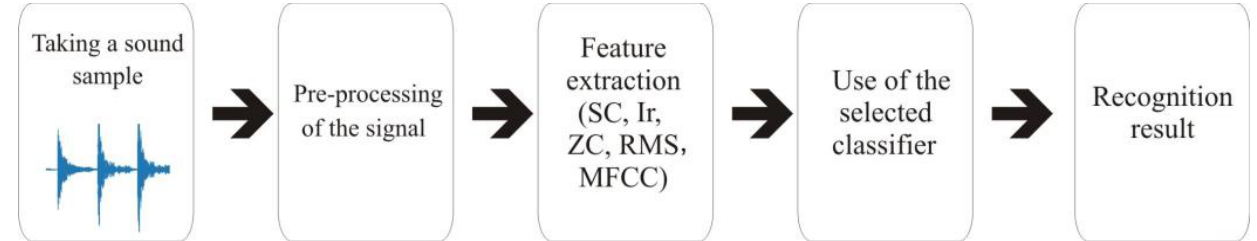
Figure 2. Diagram of experiments.